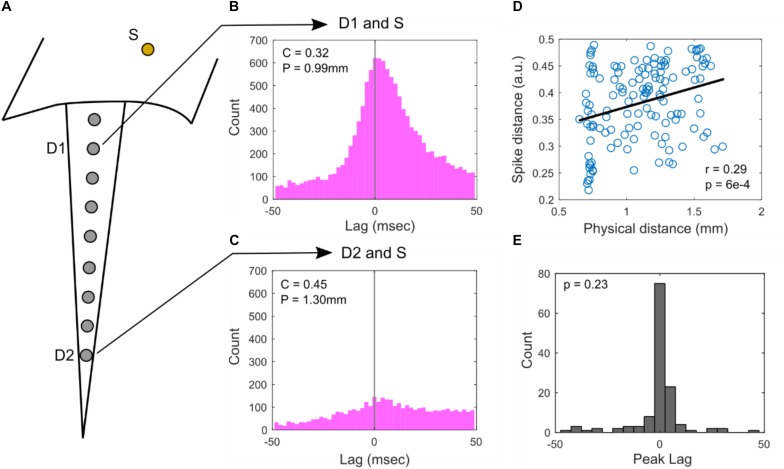
Cross-correlograms. (A) Illustration of electrode locations: surface (S) and superficial depth electrode (D1) and deep depth electrode (D2). SUAs were detected on these electrodes and their correlograms were computed in (B) and (C). (B) Cross correlation of S and D1, showing high co-occurrence. Spike distance, C and physical distance, P are relatively low. (C) Cross correlation of S and D2, showing lower co-occurrence. Spike distance, C and physical distance, P are relatively high. (D) Population analysis of all surface and depth SUA pairs comparing spike distance vs. physical distance. There is a significant Pearson correlation of r = 0.29 (p = 6e-4, n = 131, Student’s t-distribution). (E) Histogram of the peak lag appears to be positively skewed; however, the distribution does not significantly deviate from 0, suggesting no significant positive or negative lag between surface and depth units (p = 0.23, n = 131, rank-sum test).